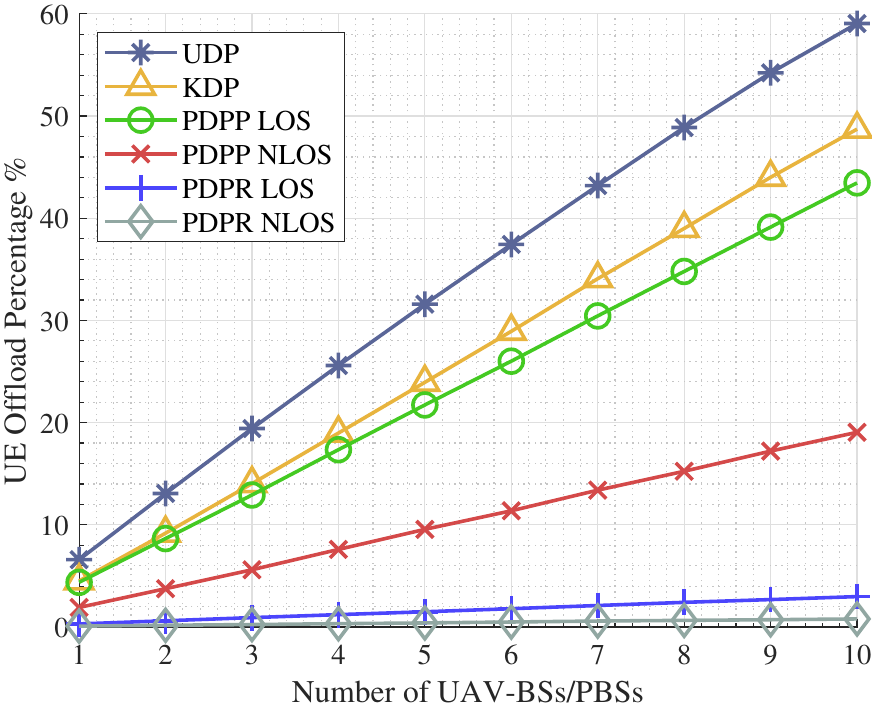
Figure 3. Percentage of UEs offloaded from the MBSs for different number of